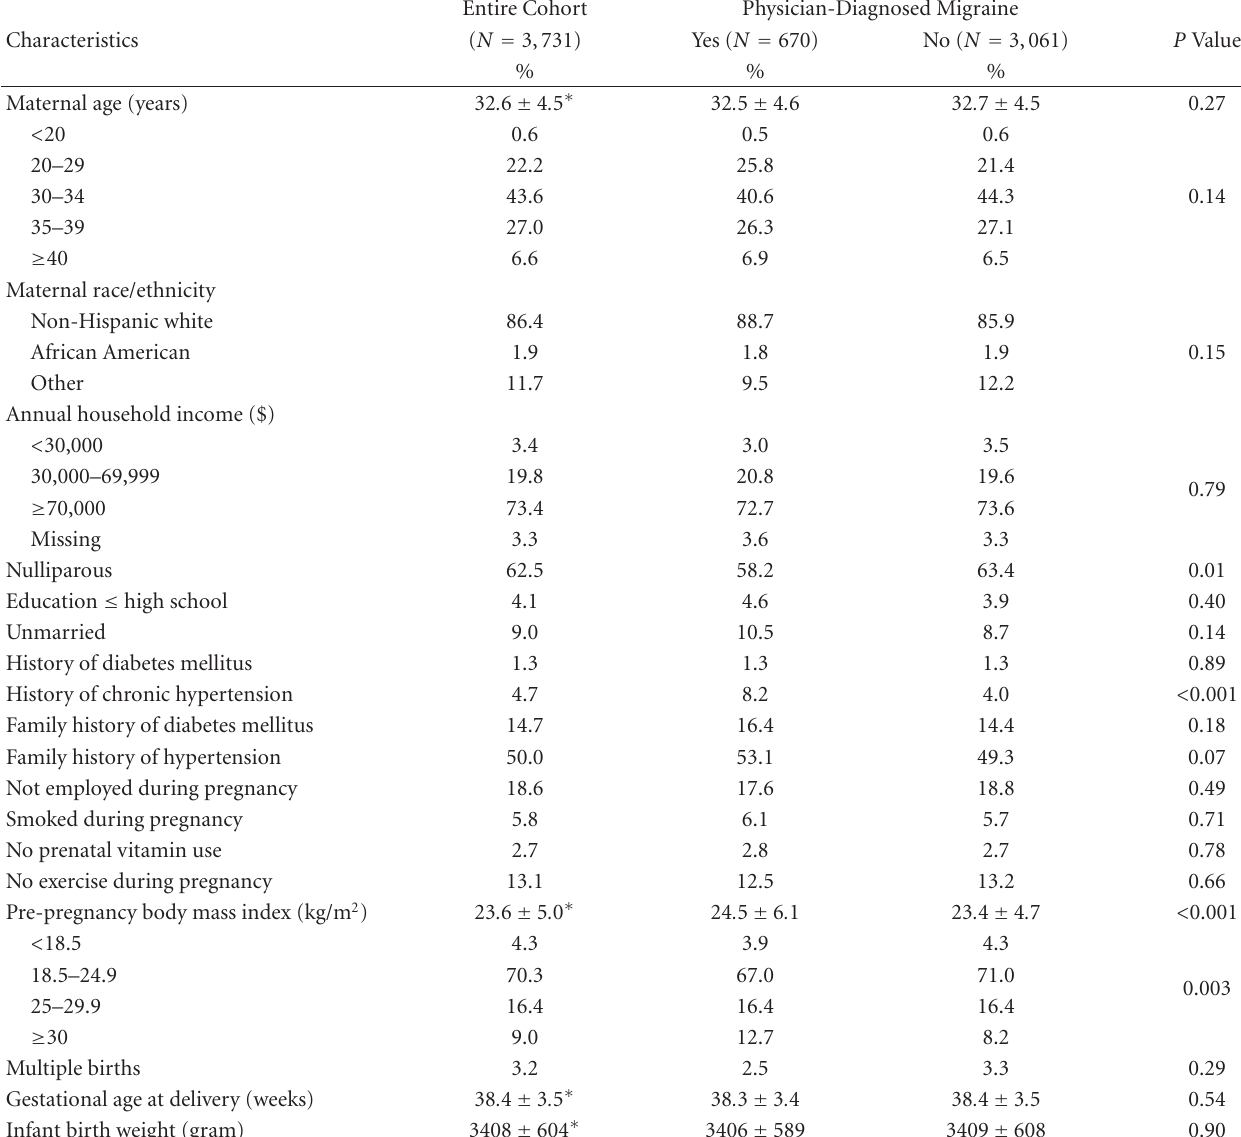
Table 1: Sociodemographic and other characteristics of the cohort, Seattle and Tacoma, WA, USA,